Question: Sum up the contents of this chart in one sentence.
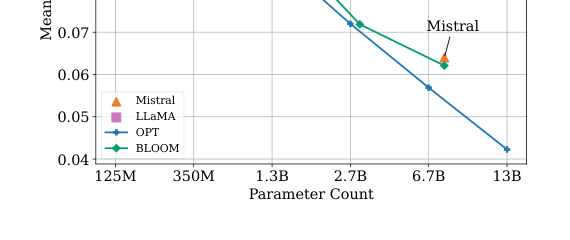
Answer: Mean Jensen-Shannon distances between full and quantized LLMs across benchmarks. The distances depict dissimilarities in true-class probability distribu- tions.